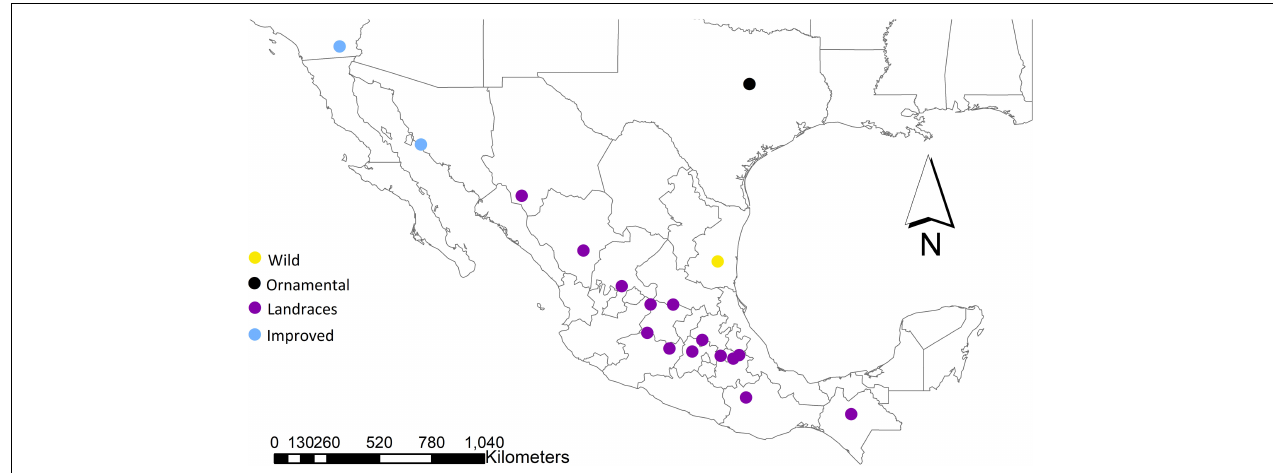
FIGURE 1 | Distribution map of the localities where the different samples of Cucurbita pepo ssp. pepo (purple for landraces, and blue for improved, i.e., commercial cultivars), C. pepo ssp. fraterna (wild, yellow), and C. pepo ssp. ovifera var. ovifera (ornamental, black) were